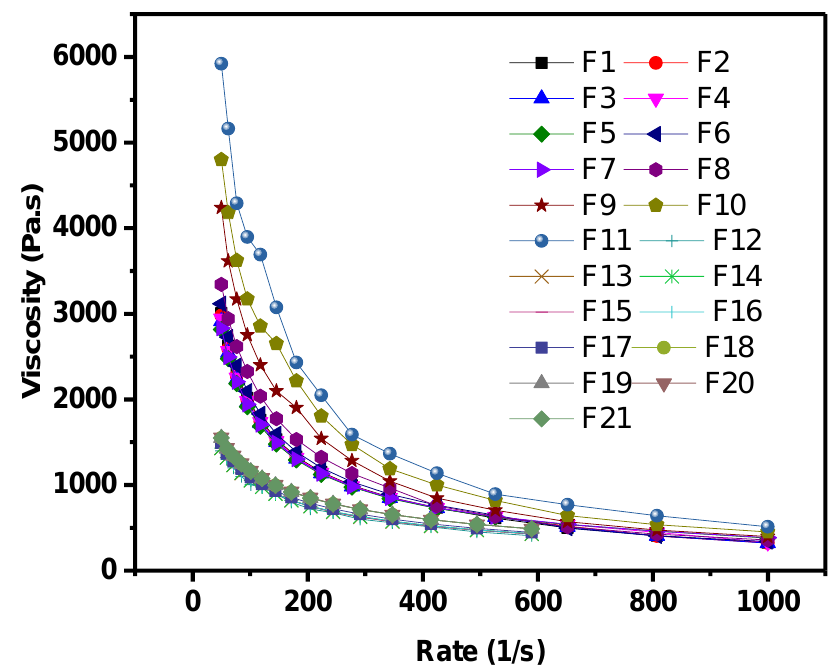
Figure 3. Viscosity of HDPE/filler composites.